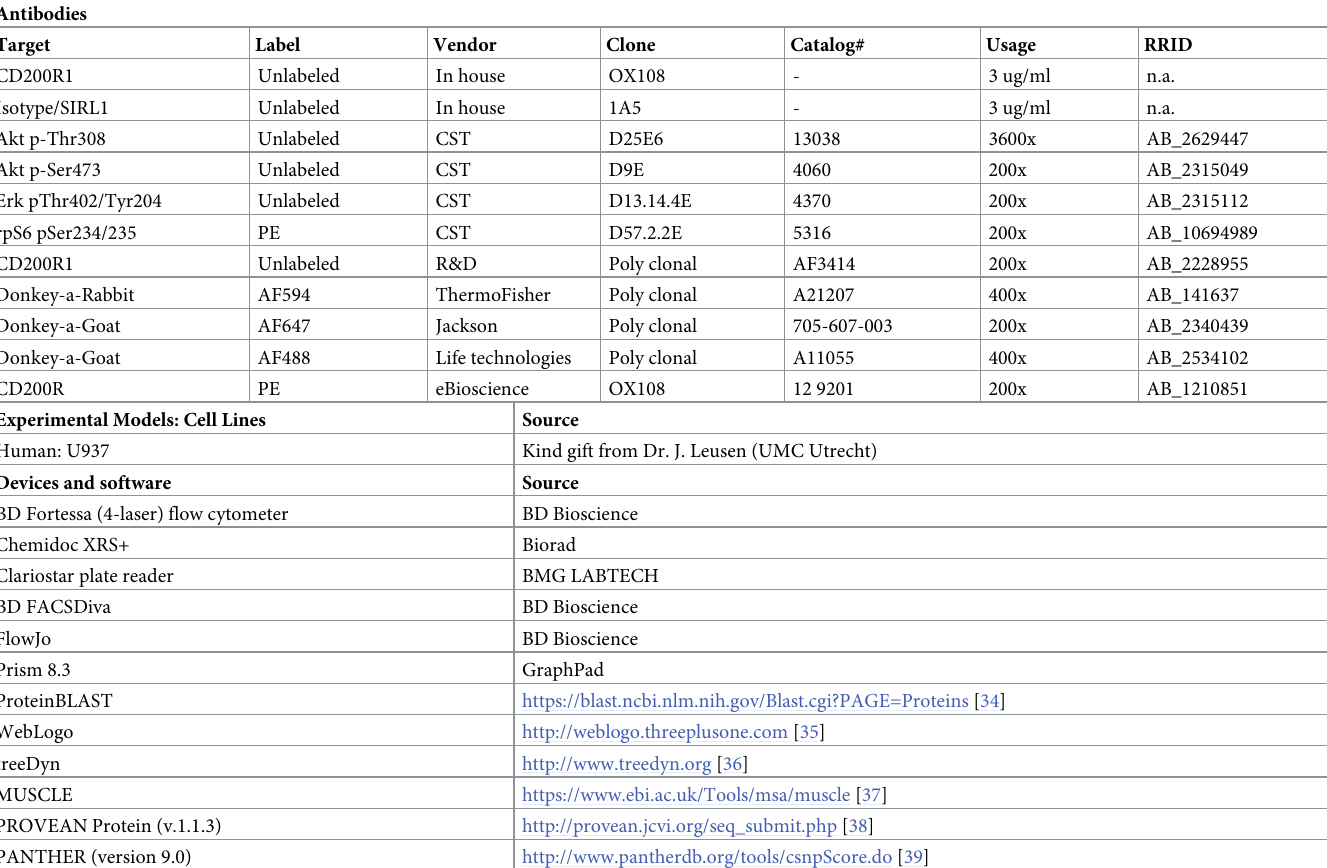
bated shaking for 16 hours at 4˚C. Cells were washed three times and incubated with a Table 3. Overview of